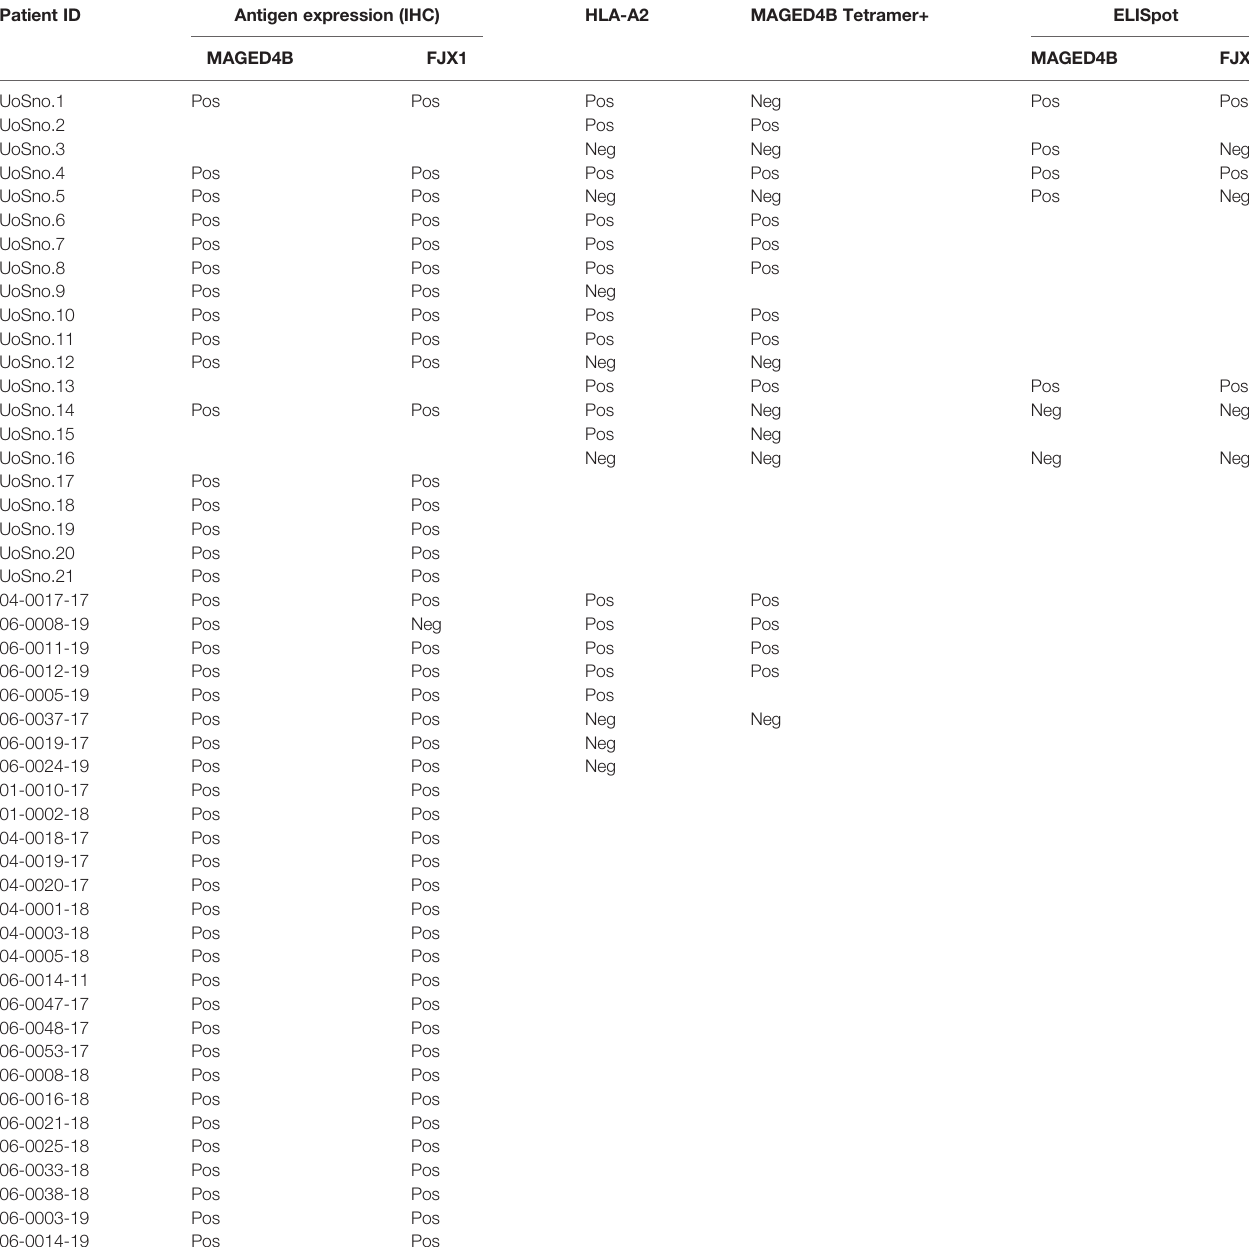
TABLE 2 | Information of target antigen expression, HLA type, and detection of antigen-speci fi c T cells in UK and Malaysia patient cohorts. Patient